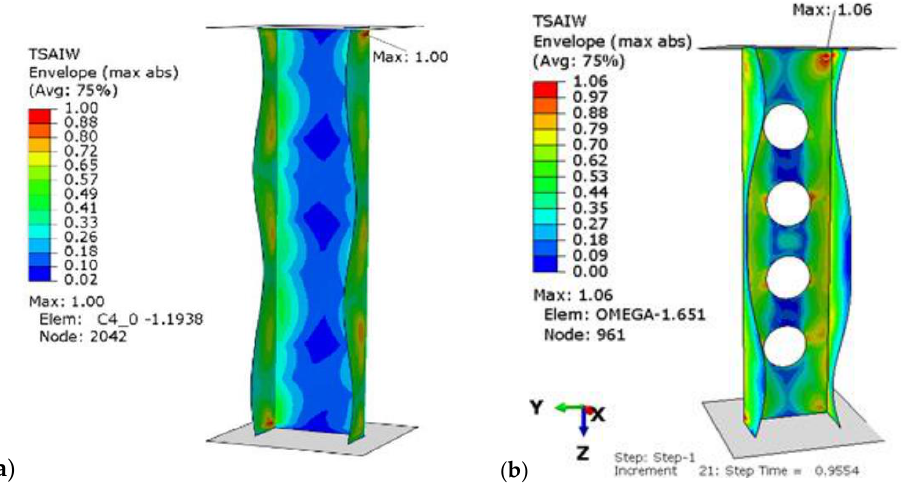
Figure 11. Tsai – Wu critical parameter map with the obtained form of loss of stability for the P2 configuration for: ( a ) unperforated, ( b ) perforated profile. configuration for: ( a ) unperforated, ( b ) perforated